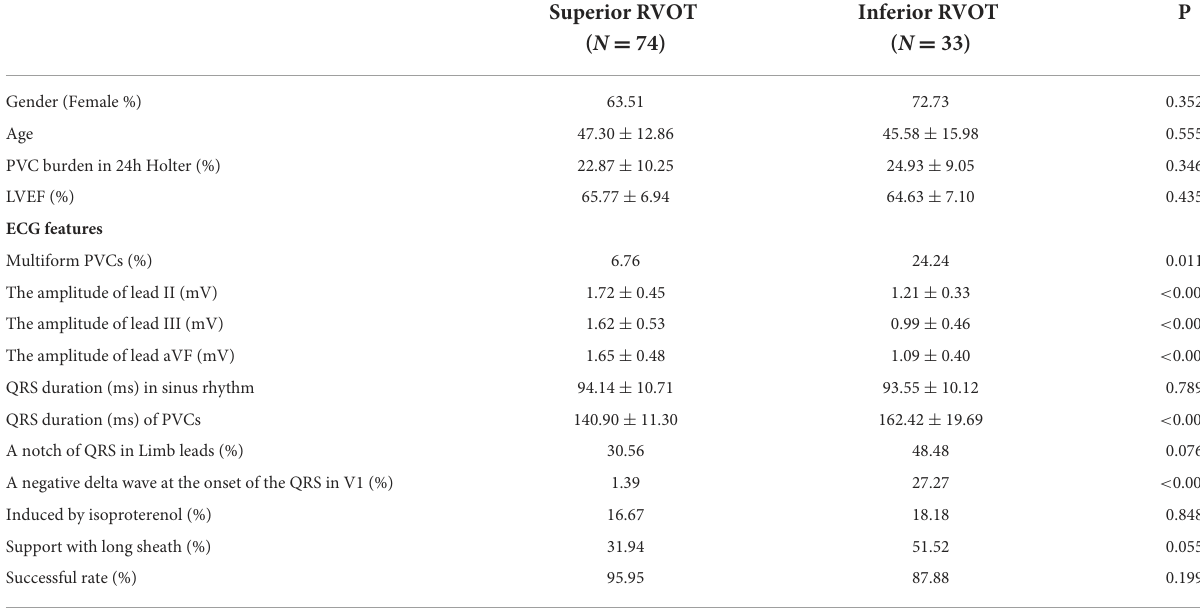
TABLE 1 Patient characteristics and ECG features of PVCs in the superior RVOT group and in the inferior RVOT group.